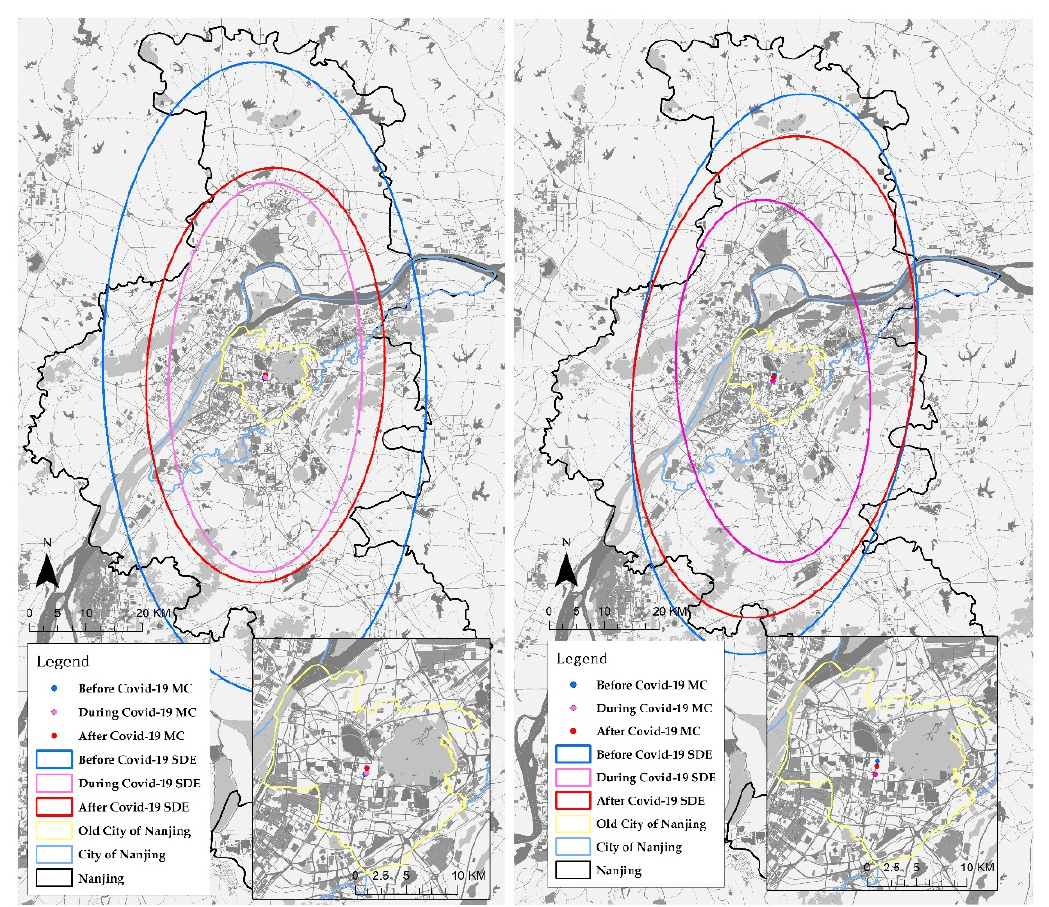
Figure 5. The results of SDE analysis by using the value of NDC ( left ) and NBC ( right ). Table 7. The results of SDE by using values of NDC and